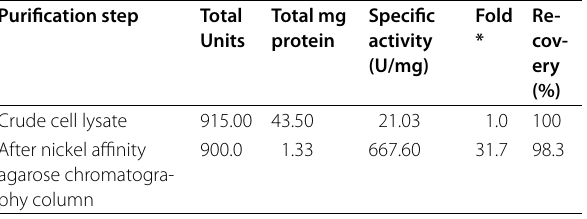
Table 2 a : Stability of Pull_Met in presence of some metal